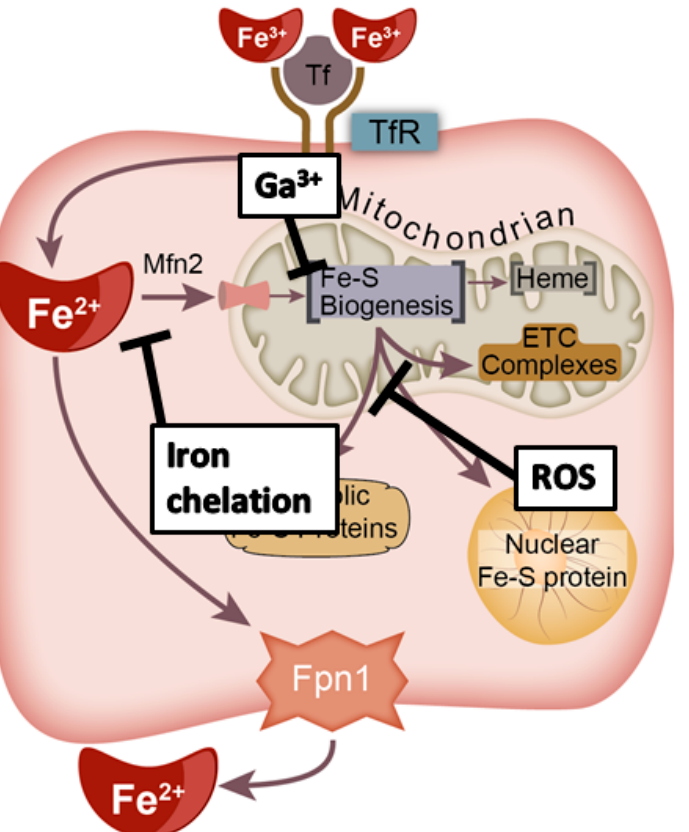
Figure 5. Therapeutic strategies to target the Fe–S biogenesis pathway. Current strategies to target the Fe–S biogenesis pathway to induce cancer cell killing include Fe chelation to prevent intracellular trafficking, iron mimicry in the form of Ga 3+ to function as a Fe antagonist and impair the Fe–S biogenesis process, and pro-oxidants (e.g., ionizing radiation) to perturb Fe–S containing proteins.